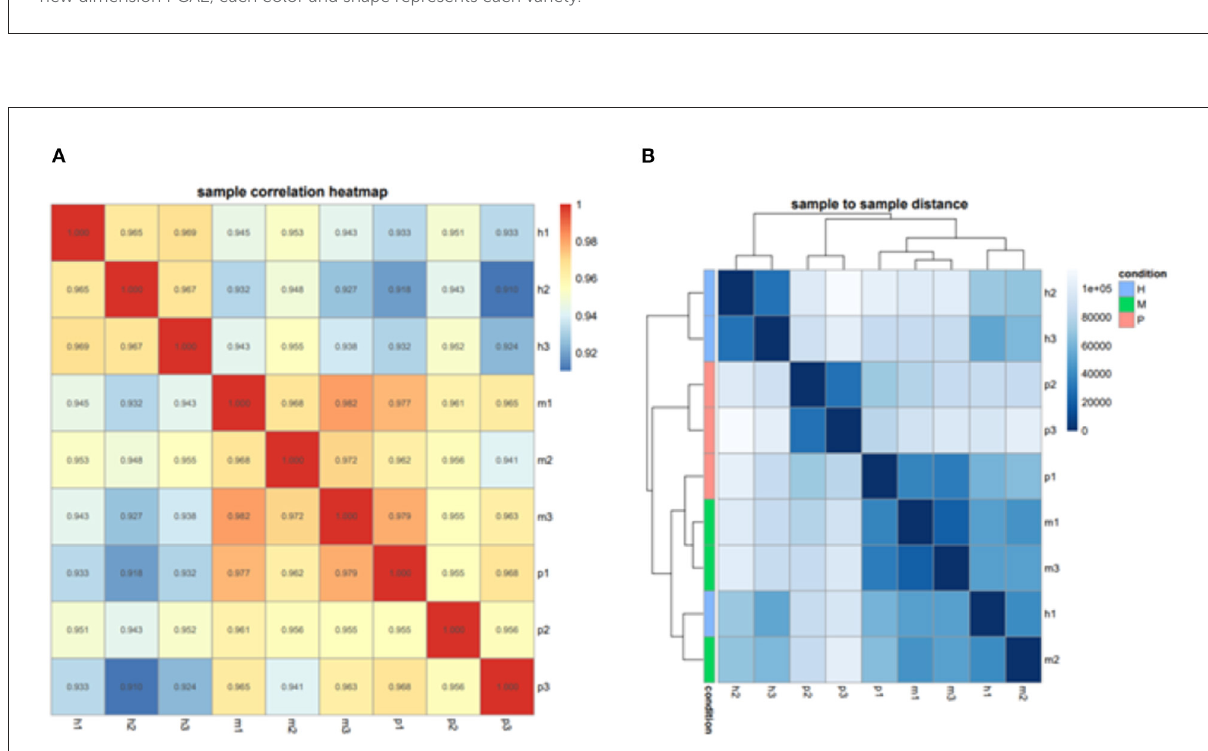
FIGURE3 The RPM distribution and principal component of nine samples. (A) The RPM boxplot of nine samples, the x- axis represents each sample, and the y- axis represents log 10 RPM. (B) Principal component analysis of nine samples, the x- axis represents the PCA1, and the y- axis represents the new dimension PCA2, each color and shape represents each variety.